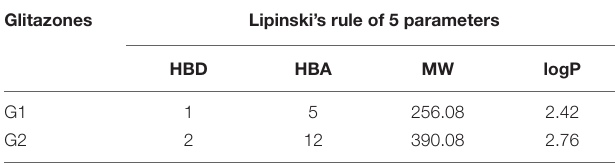
TABLE 3 | In sillco drug likeness analysis of novel glitazones.